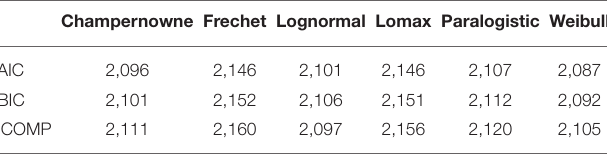
TABLE 11 | Simulation: Information criteria for Champernowne, Frechet, Lognormal, Lomax, Paralogistic, and Weibull models. Champernowne Frechet Lognormal Lomax Paralogistic Weibull